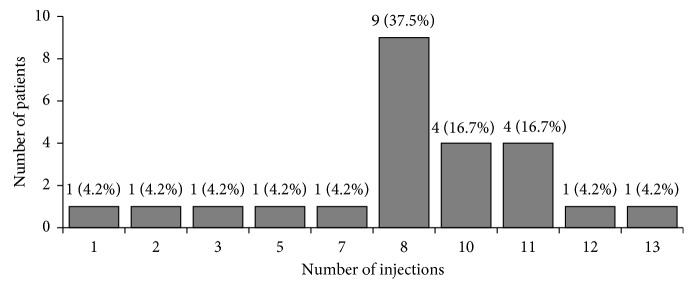
Number of aflibercept injections received by patients during the trial.